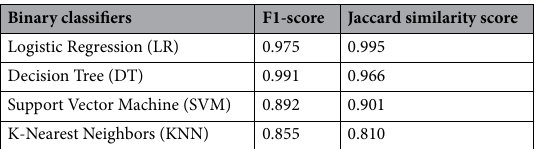
Table 2. Comparison of the performances of ML